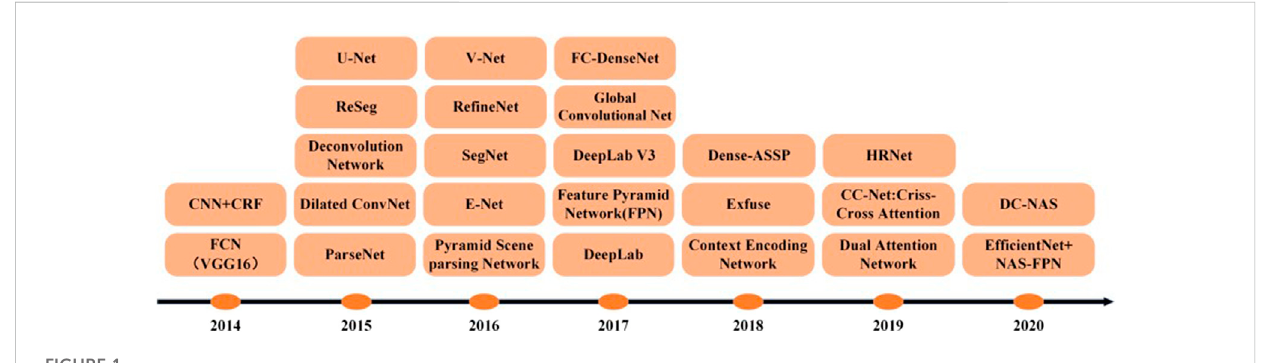
FIGURE 1 The timeline of DL-based segmentation model for 2D